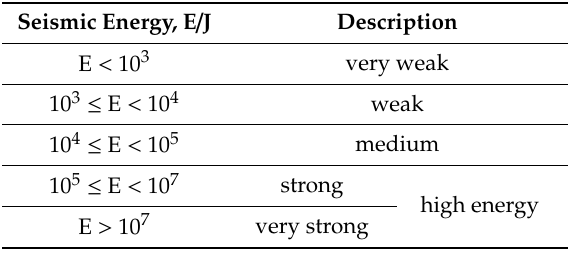
Table 1. Energy classification of rock mass shocks